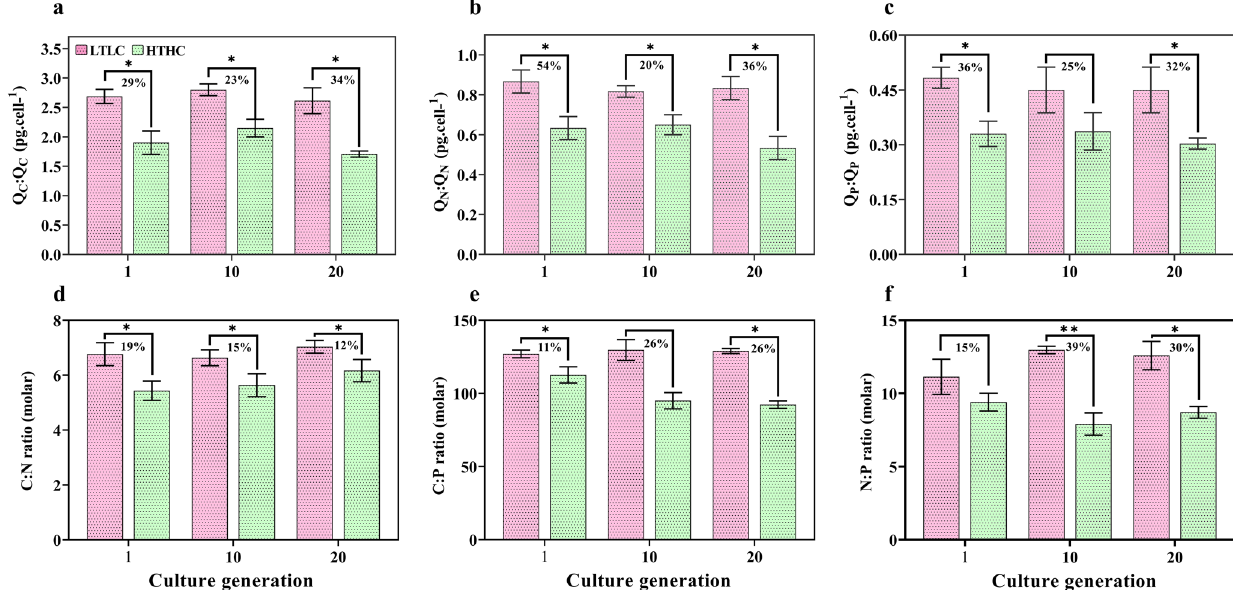
Fig. 2 Elements and stoichiometry changes in Heterosigma akashiwo grown to different generations under LTLC and HTHC conditions. a carbon ( b ) nitrogen, ( c ) phosphorus quotas, and ( d ) cellular carbon:nitrogen, ( e ) cellular carbon:phosphorus, and ( f ) cellular nitrogen:phosphorus stoichiometry. The percentages indicate comparison values between the LTLC and HTHC samples. Signi fi cant differences for each parameter relative to the control are denoted by ∗ p < 0.05 and ∗∗ p <